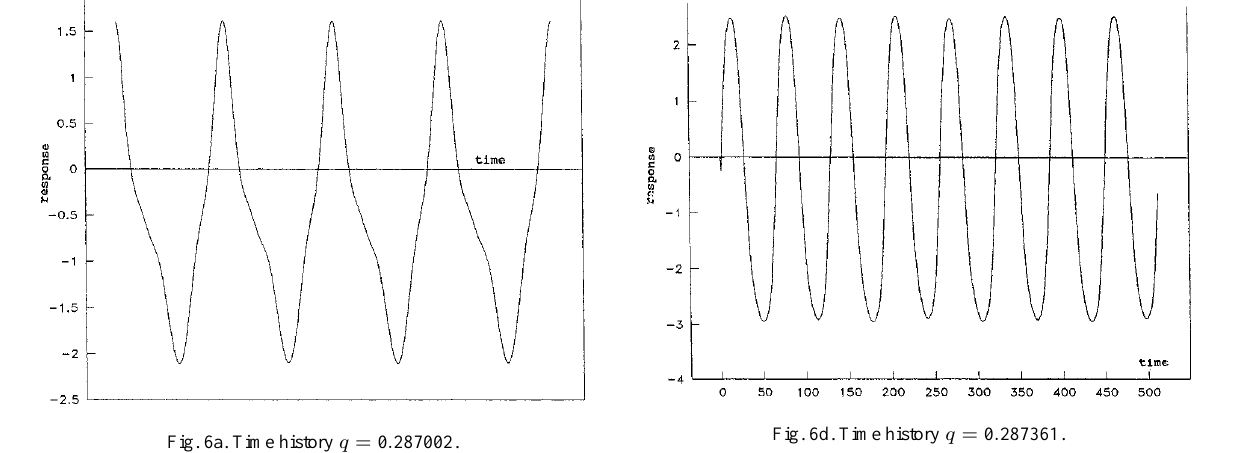
Fig. 6a. Time history q = 0 : 287002.